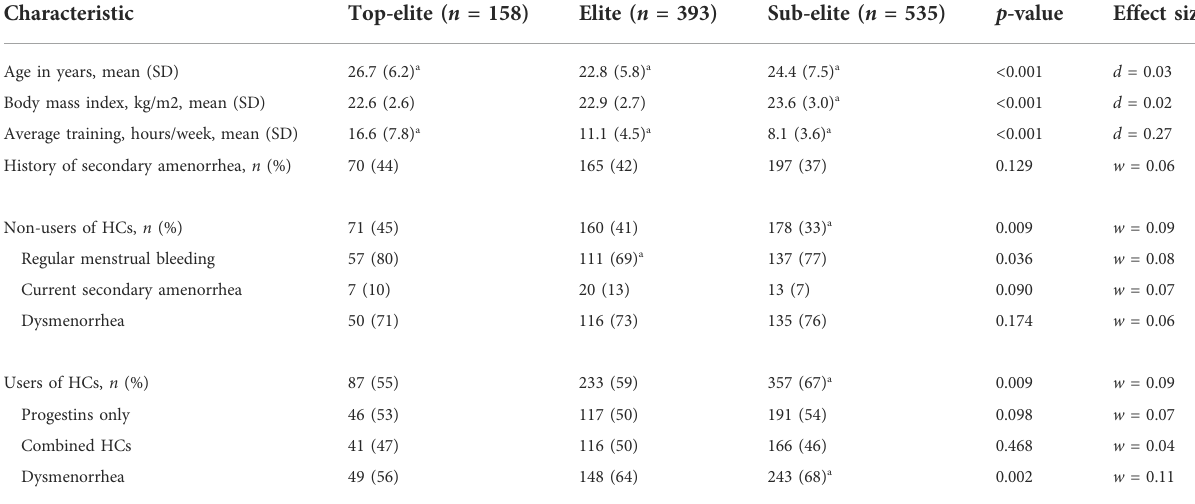
TABLE 4 Demographic characteristics of the athletes ’ competitive levels. Top-elite: Olympic games, World championships, and/or European championships. Elite: other international competitions, Swedish or Norwegian championships, the highest national league. Sub-elite: the next highest national league, and district